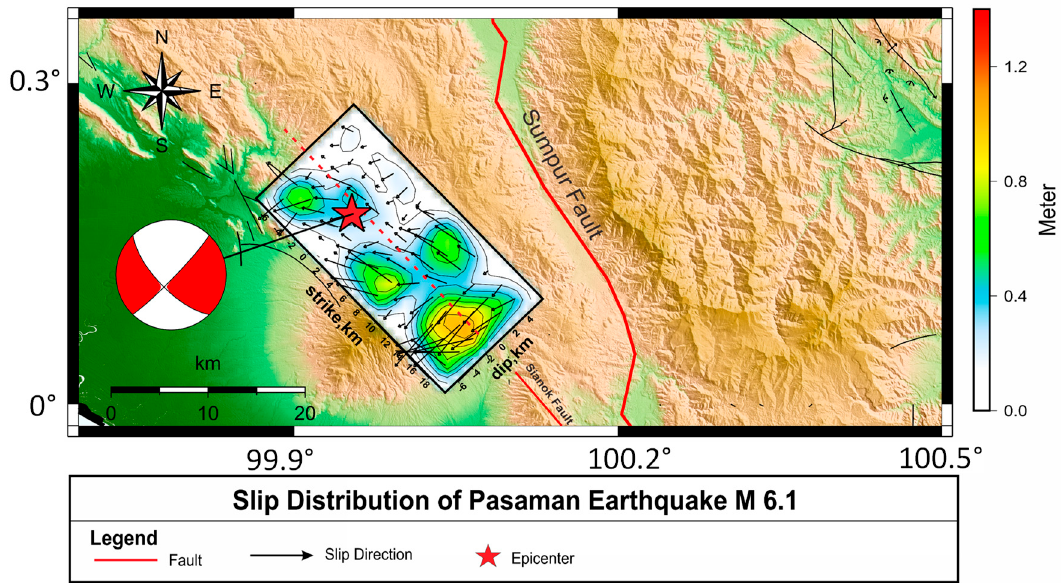
Figure 9. Finite-fault model of teleseismic body wave inversion. The red star represents the epicenter